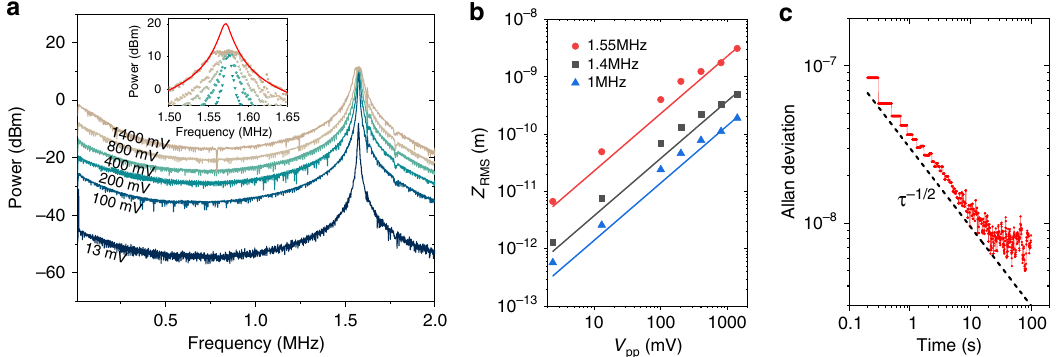
Fig. 6 Response of the sensor driven by an oscillating voltage. a Driven-response spectra for various driving amplitude measured with a 50 Hz resolution bandwidth. A − 1 V DC bias is applied for V pp from 13 mV to 800 mV. For V pp = 1.4 V a − 1.4 V DC bias is used. Inset: Zoom-in of the spectra around at the resonance, with a Lorentzian fi t of the 1.4 V modulation data. Laser wavelength is 1540 nm and on-chip power 0.3 mW. b Root mean square displacement of cantilever as a function of peak-to-peak voltage at 1.55 MHz, 1.4 MHz and 1 MHz. Dots are measurement data and solid lines are linear fi ts. c Allan deviation as a function of integration time. The τ − 1/2 slope is indicated with dashed line, where τ is the integration